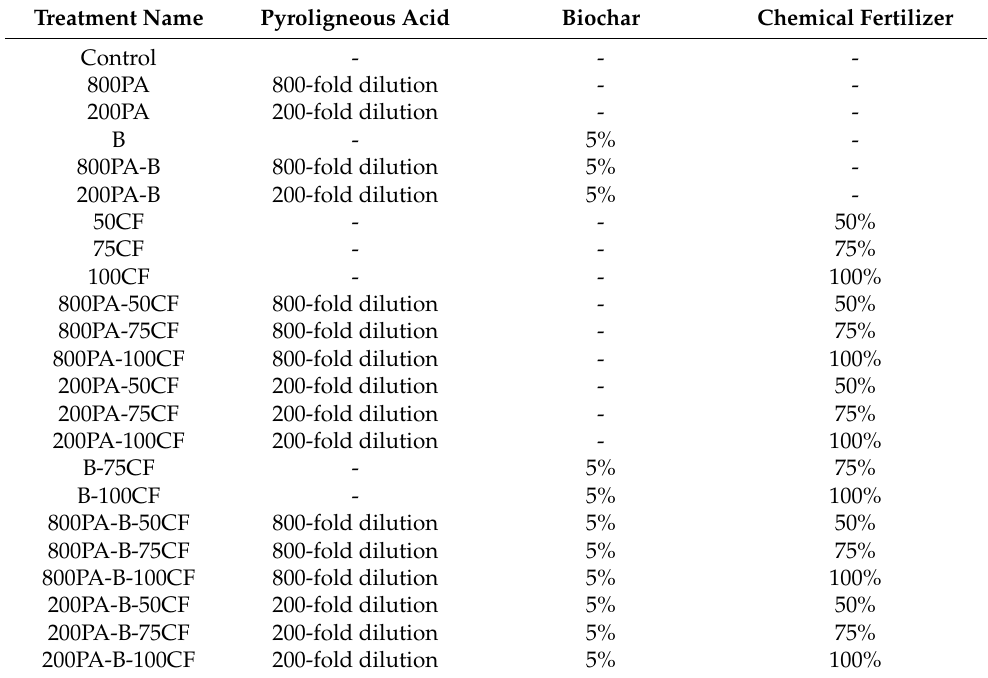
Table 1. Different treatment combinations of pyroligneous acid (PA), biochar (B), and chemical fertilizer (CF). Percentages in the column of Biochar and Chemical Fertilizer represent proportions of these inputs applied within respective